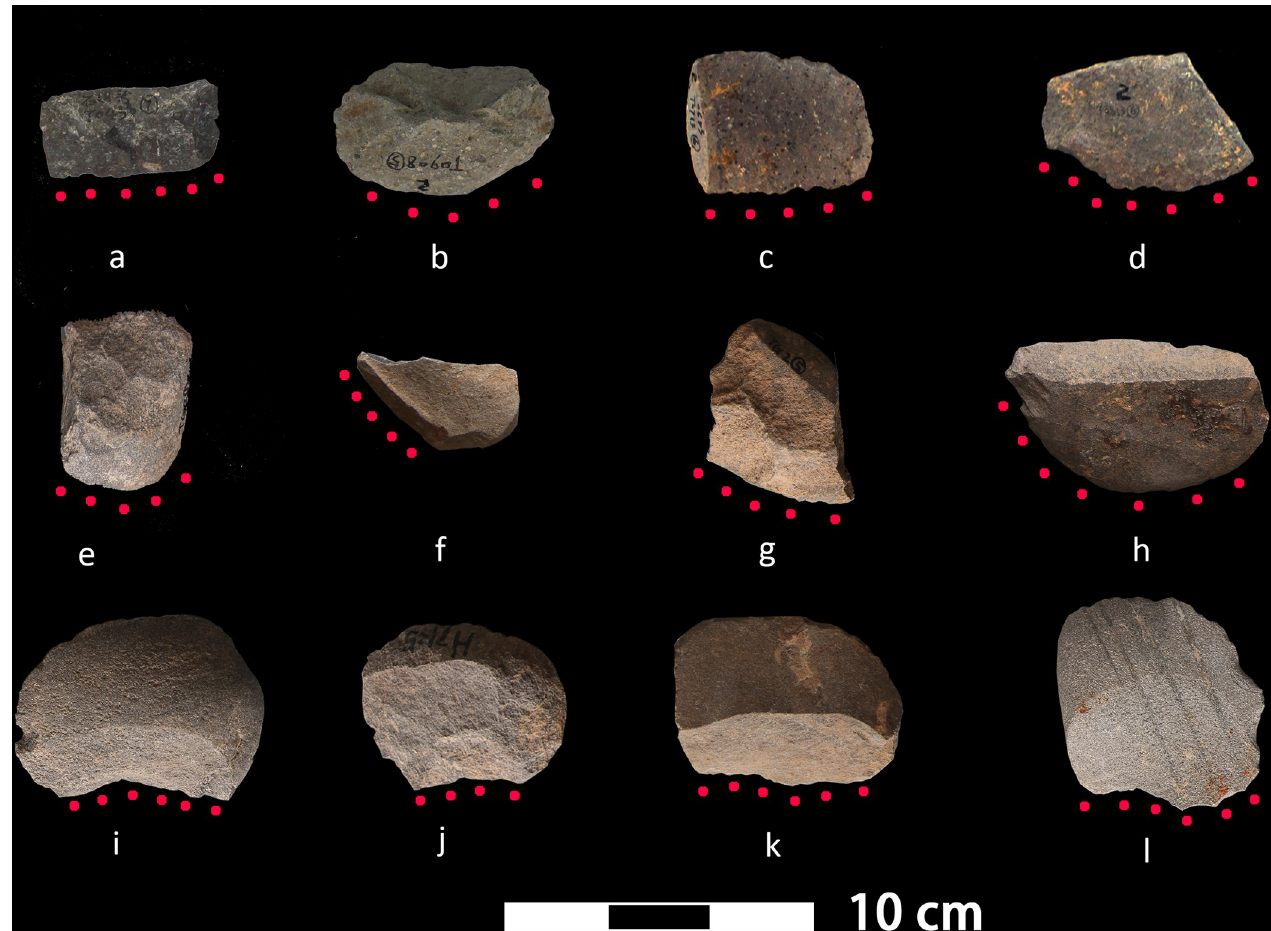
Fig 2. A selection of stone flakes analyzed in this study. (a)-(h) Flakes from the Shangshan culture; (i)-(l) Flakes from the Kuahuqiao culture. Red dots delineate working edges.